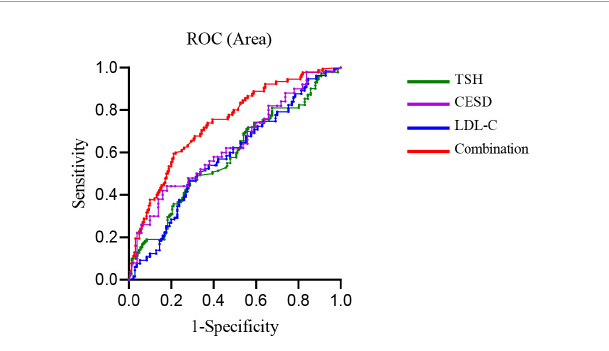
FIGURE1 The receiver operating characteristic (ROC) curve. The ROC curve was used to determine the discriminatory capacity of parameters to distinguish between suicide attempters and non-suicide attempters. The area under the ROC curve (AUC) of thyroid-stimulating hormone (TSH), low-density lipoprotein cholesterol (LDL-C), Epidemiological Studies Depression Scale (CES-D) total score, and the combination of these three parameters were 0.60, 0.60, 0.68, and 0.74,